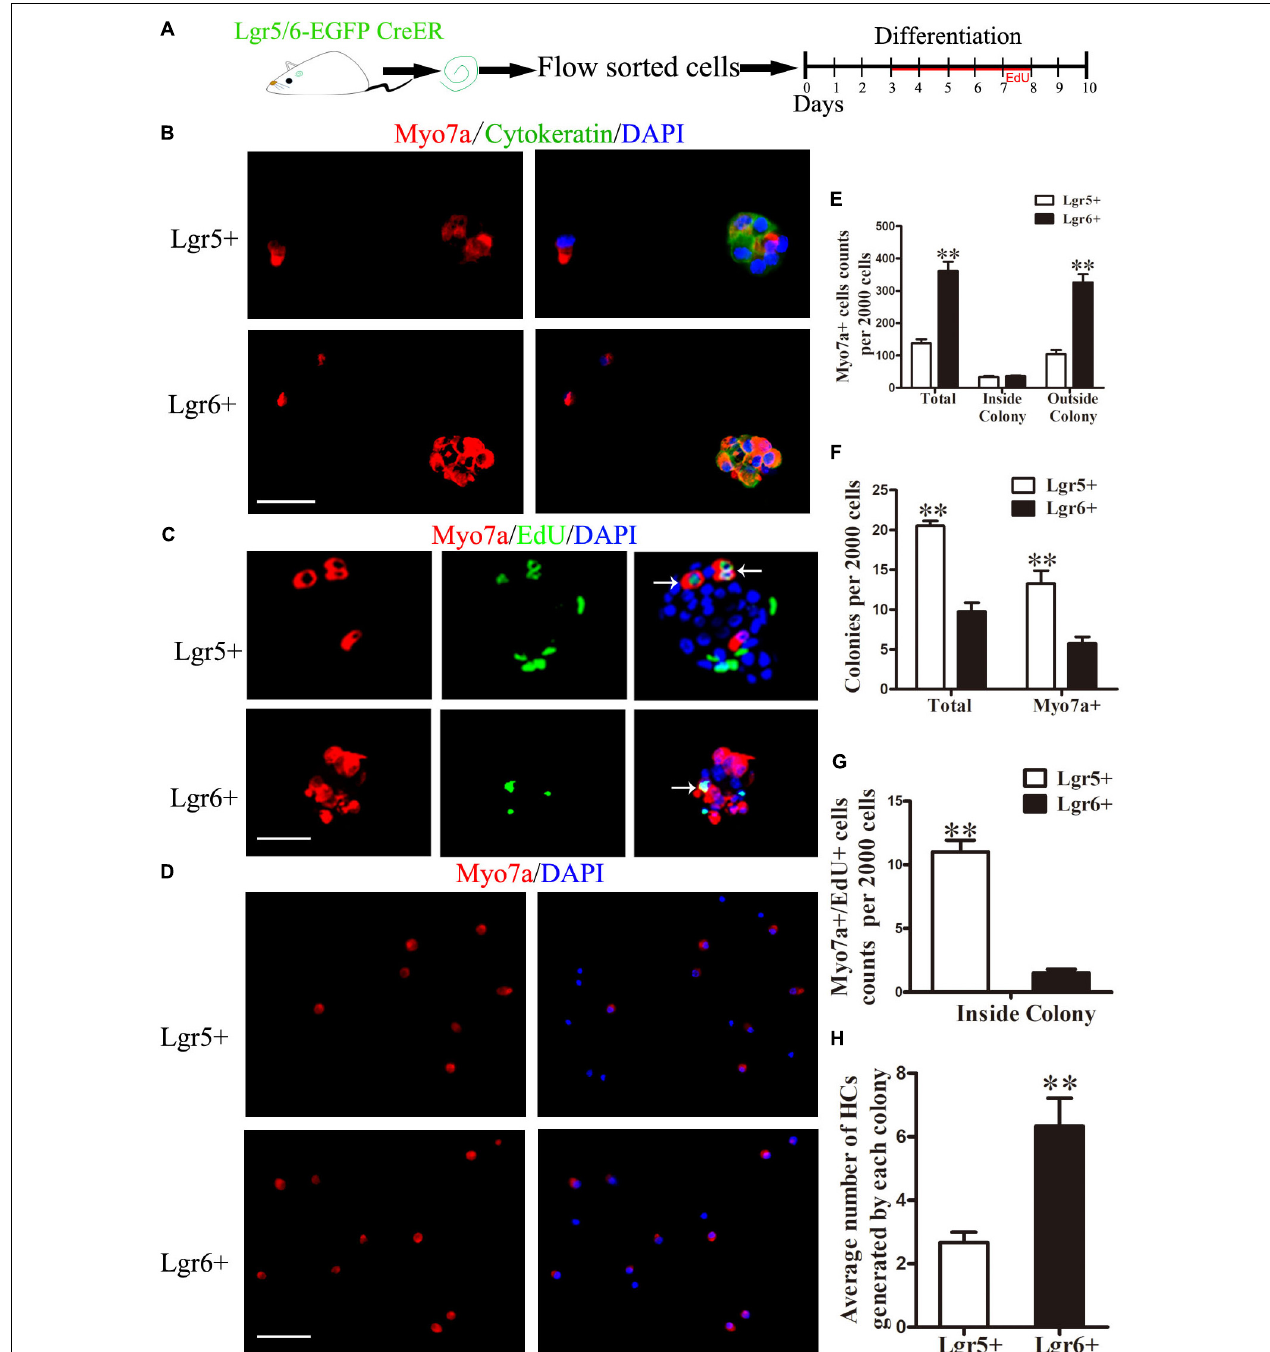
FIGURE 2 | Lgr6+ progenitors generate more HCs compared to Lgr5+ progenitors in vitro. (A) Schematic depicting the experimental process. We dissected the cochleae and then cultured the sorted GFP+ cells at 20 cells/ µ l for 10 days. (B) Both Lgr5+ and Lgr6+ progenitors could generate Myo7a+ colonies. (C) Both Lgr5+ and Lgr6+ progenitors could generate Myo7a+/EdU+ cells inside of the colonies. (D) Both Lgr5+ and Lgr6+ progenitors could generate Myo7a+ cells outside the colonies. (E) The total number of Myo7a+ cells in each well per 2,000 cells and the numbers of Myo7a+ cells inside and outside the colonies. The Lgr5+ progenitors formed around 140 Myo7a+ cells per 2,000 cells and about 33 Myo7a+ cells inside the colonies, while the Lgr6+ progenitors formed around 360 Myo7a+ cells per 2,000 cells and about 36 Myo7a+ cells inside the colonies. (F) The numbers of colonies in each well per 2,000 cells. The Lgr5+ progenitors formed around 20 colonies and 10 Myo7a+ colonies, while the Lgr6+ progenitors formed around 13 colonies and 6 Myo7a+ colonies. (G) Lgr5+ progenitors generated significantly more Myo7a+/EdU+ cells than Lgr5+ progenitors inside of the colonies (11.0 ± 0.91 and 1.5 ± 0.29 HCs, respectively). (H) Each Myo7a+ colony from the Lgr6+ progenitors generated significantly more HCs than the Myo7a+ colonies from Lgr5+ progenitors. ∗∗ p < 0.01, n = 4. Scale bars are 20 µ m.